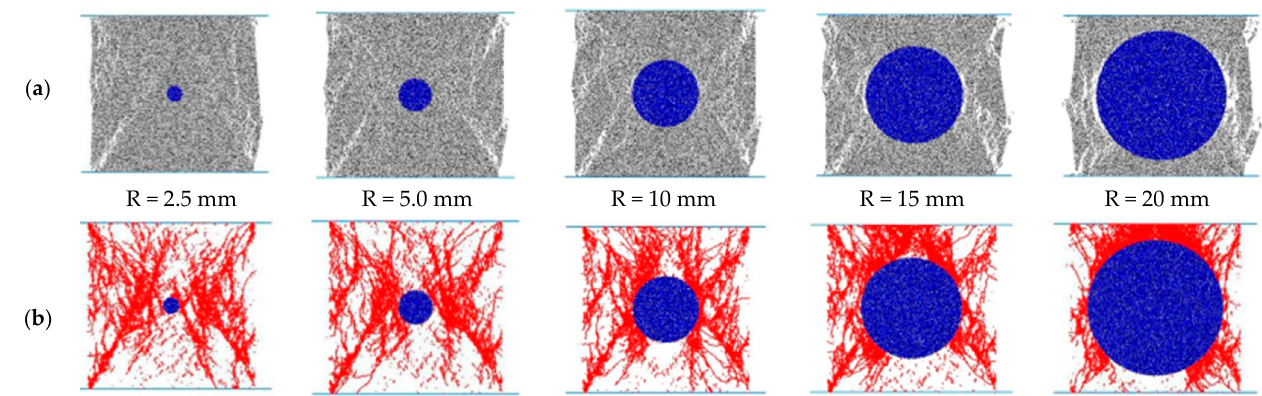
Figure 7. Typical failure modes of specimens in Group 2: ( a ) failure mode of specimen; ( b ) failure mode of concretion.